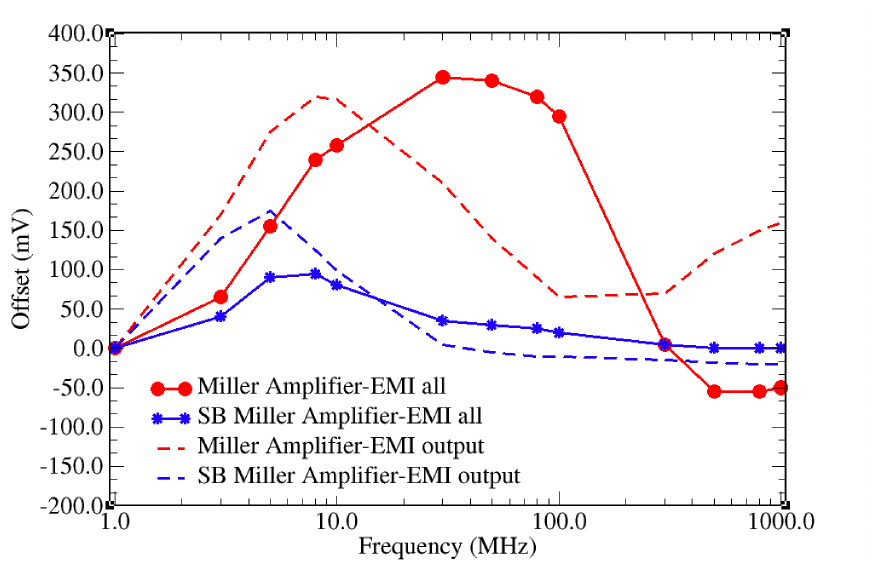
Figure 7. Offset induced by 900 mVpp EMI coupled from the ground plane of a classic and SB Miller